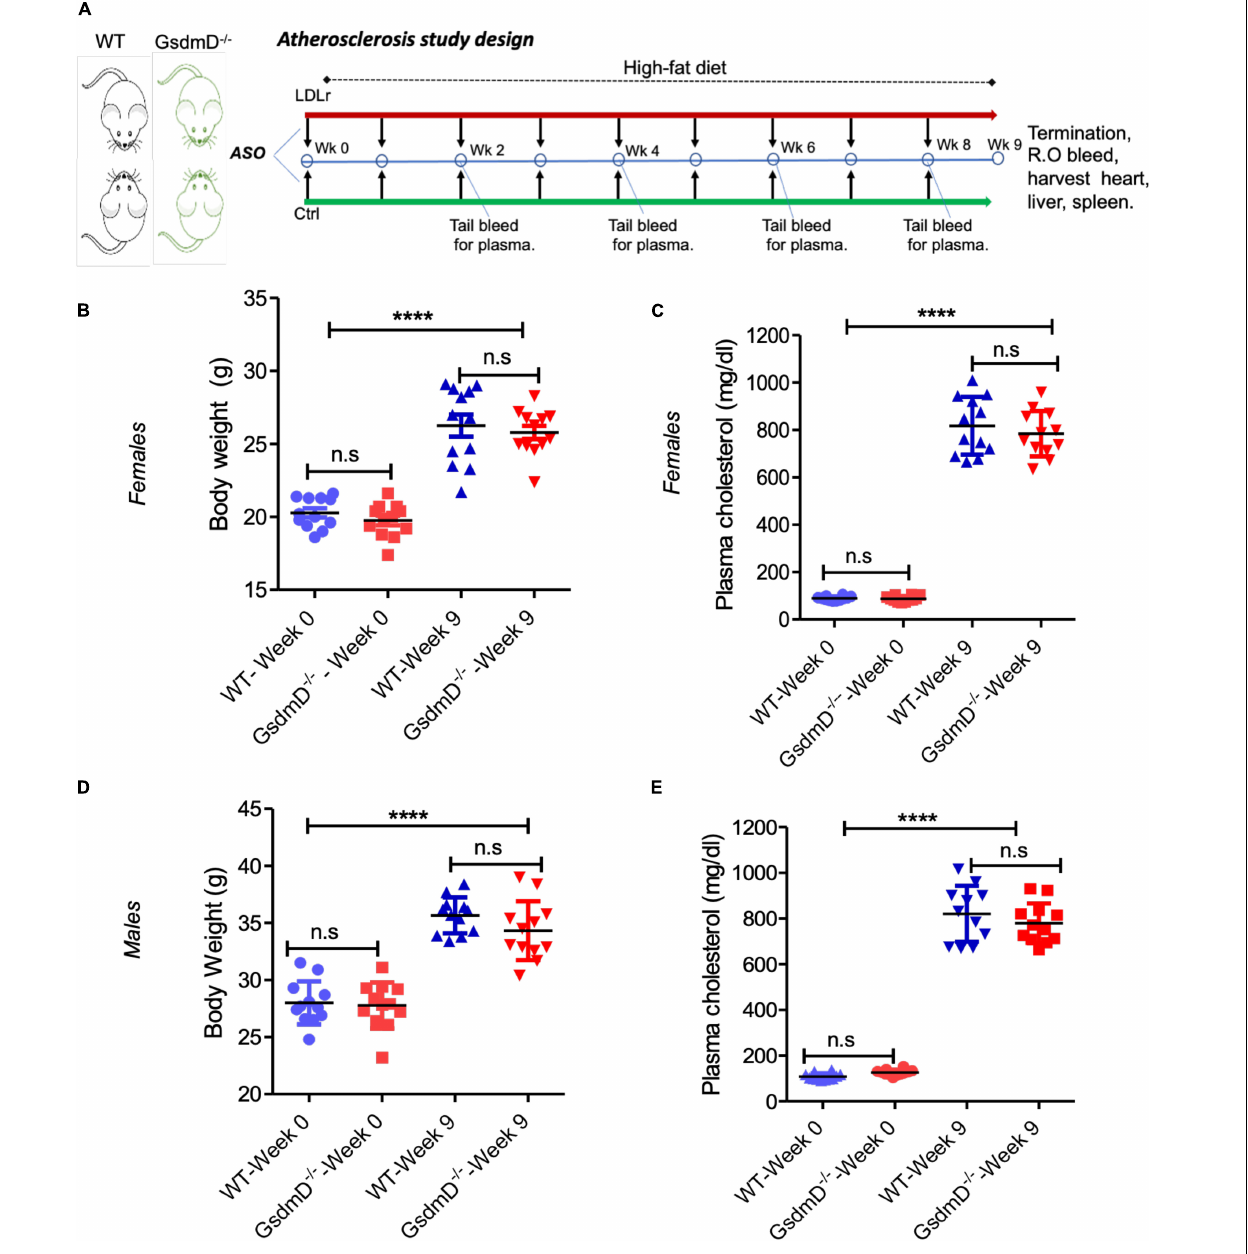
FIGURE 5 | Low-density lipoprotein receptor (LDLr) ASO generates hyperlipidemia in both WT and GsdmD - / - KO mice. (A) Schematic representation of mouse atherosclerosis study design. The 12-week-old mice from both sexes were injected with either control or LDLr ASO for 9 weeks. The mice were fed western type diet throughout the course of study. The body weight in females (B) and total plasma cholesterol levels (C) at week 0 and at the end of experiment, indicated by week 9, (mean ± SD, N = 12, **** p < 0.0001 by two-tailed t -test, n.s = non-significant), and male data for body weight (D) and total plasma cholesterol levels (E) is presented at base and final levels ( N = 12, **** p < 0.0001 by two-tailed t -test for both WT-week 0 vs. WT-week 9 and GsdmD - / - -week 0 vs. GsdmD - / - -week 9, n.s = non-significant by two-tailed t